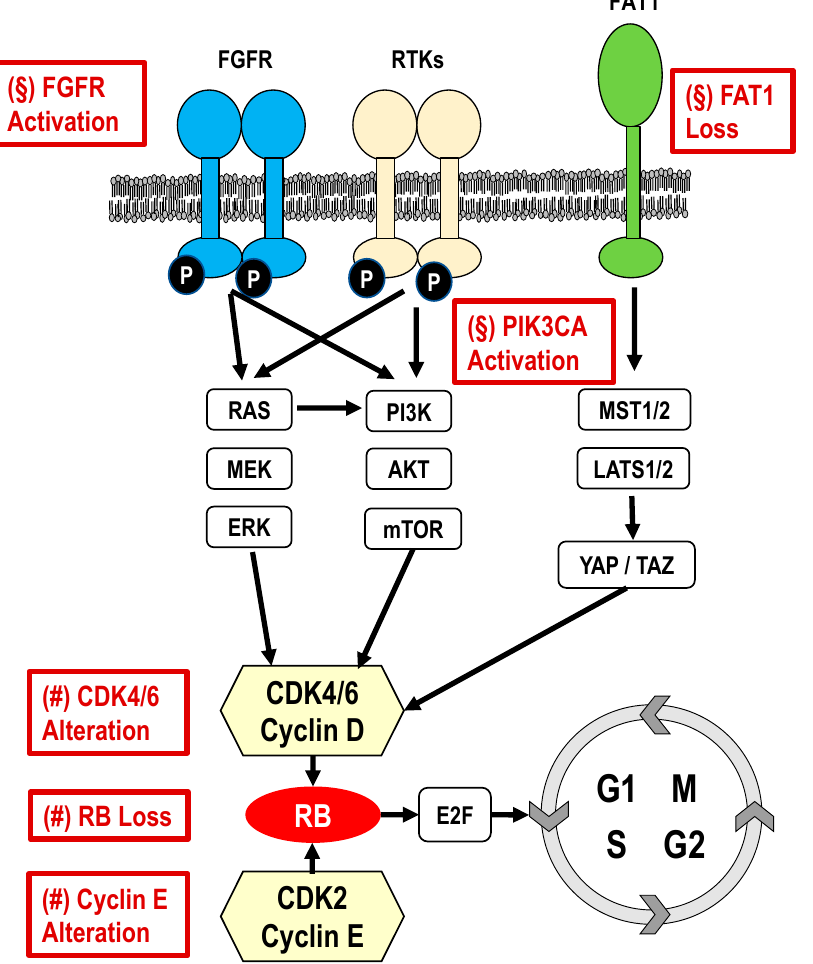
Figure 3. Summary of the main mechanisms potentially implicated in the resistance to CDK4/6 inhibitors: (§) Cell cycle-non-specific mechanisms; (#) Cell cycle-specific mechanisms.